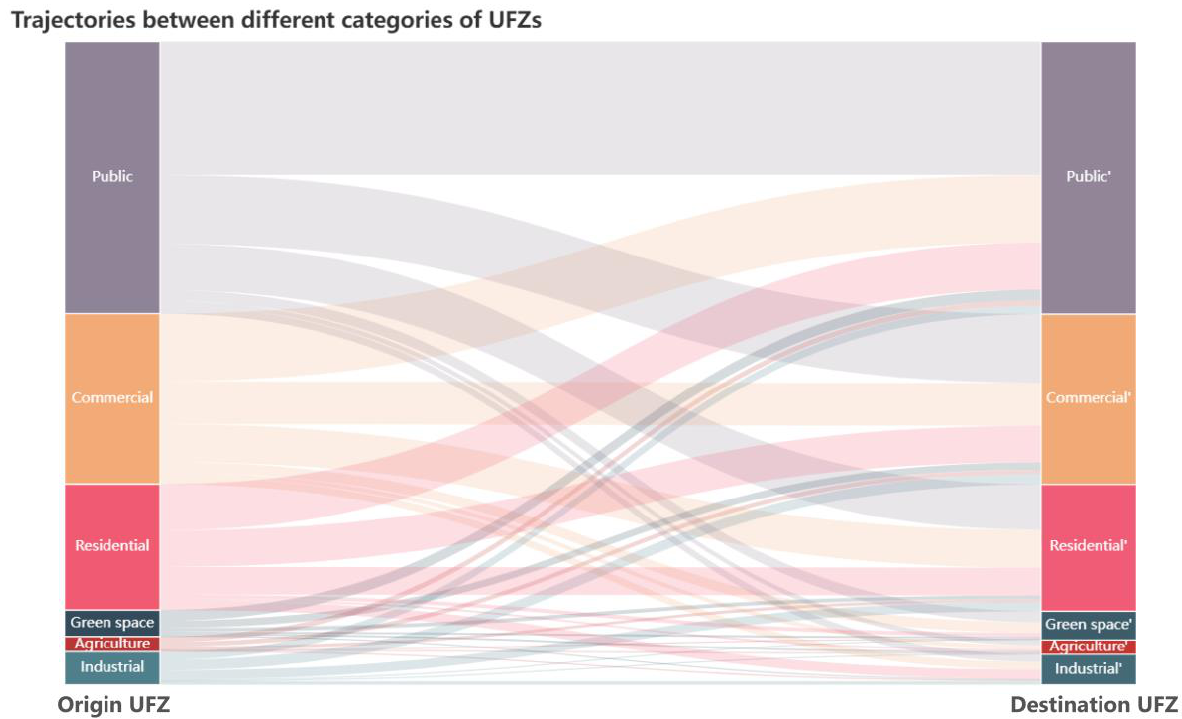
Figure 13. Sankey diagram of mobility flow between UFZs in